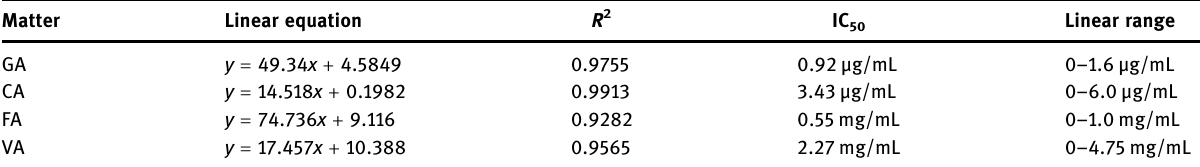
Table 7: The linear relationship of four polyphenolic compounds on DPPH free radical clearance